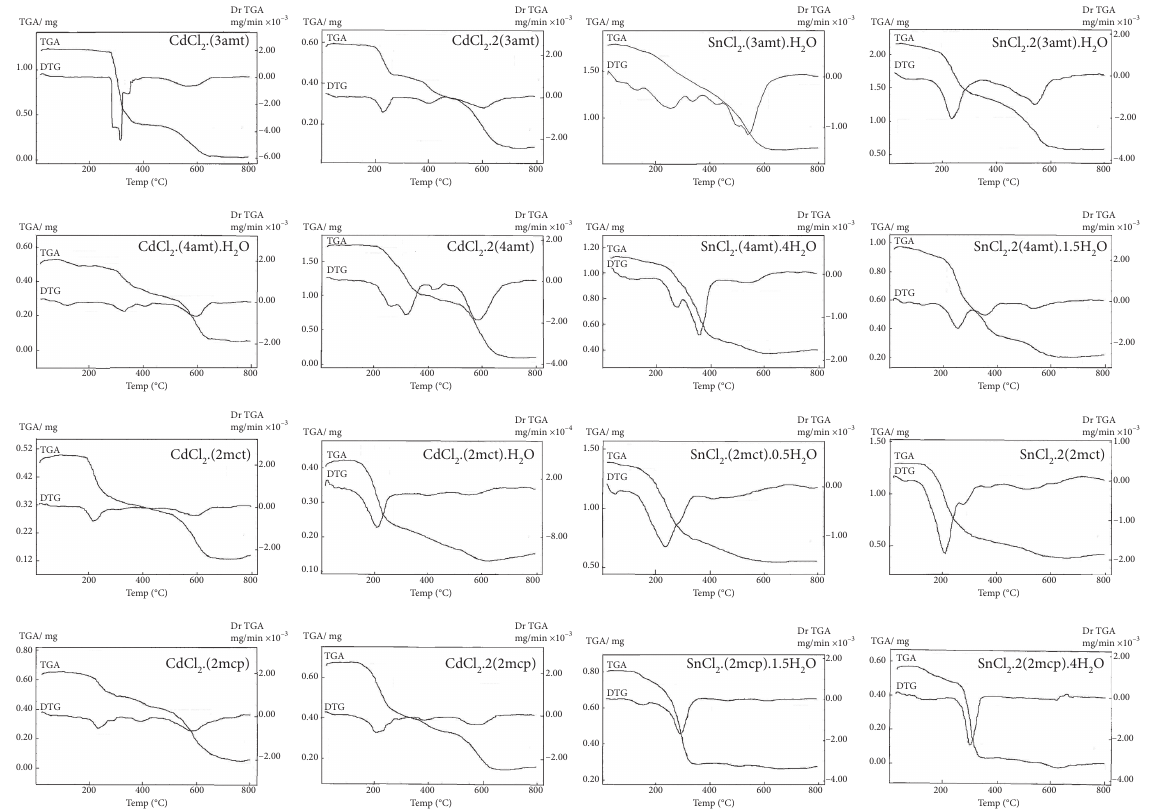
Figure 4: Thermogravimetric curves for the 16 solid adducts. Table 6: TG data summary for Sn(II) and Cd(II) adducts with 3amt, 4amt, 2mcp, and